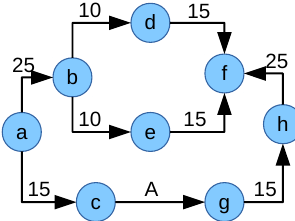
Figure 14. Topology of scenarios 5 to 8: all stations in a line. The numbers specify the link speeds in Mbps. Scenarios 5 and 6: A = 10; Scenarios 7 and 8: A = 20.